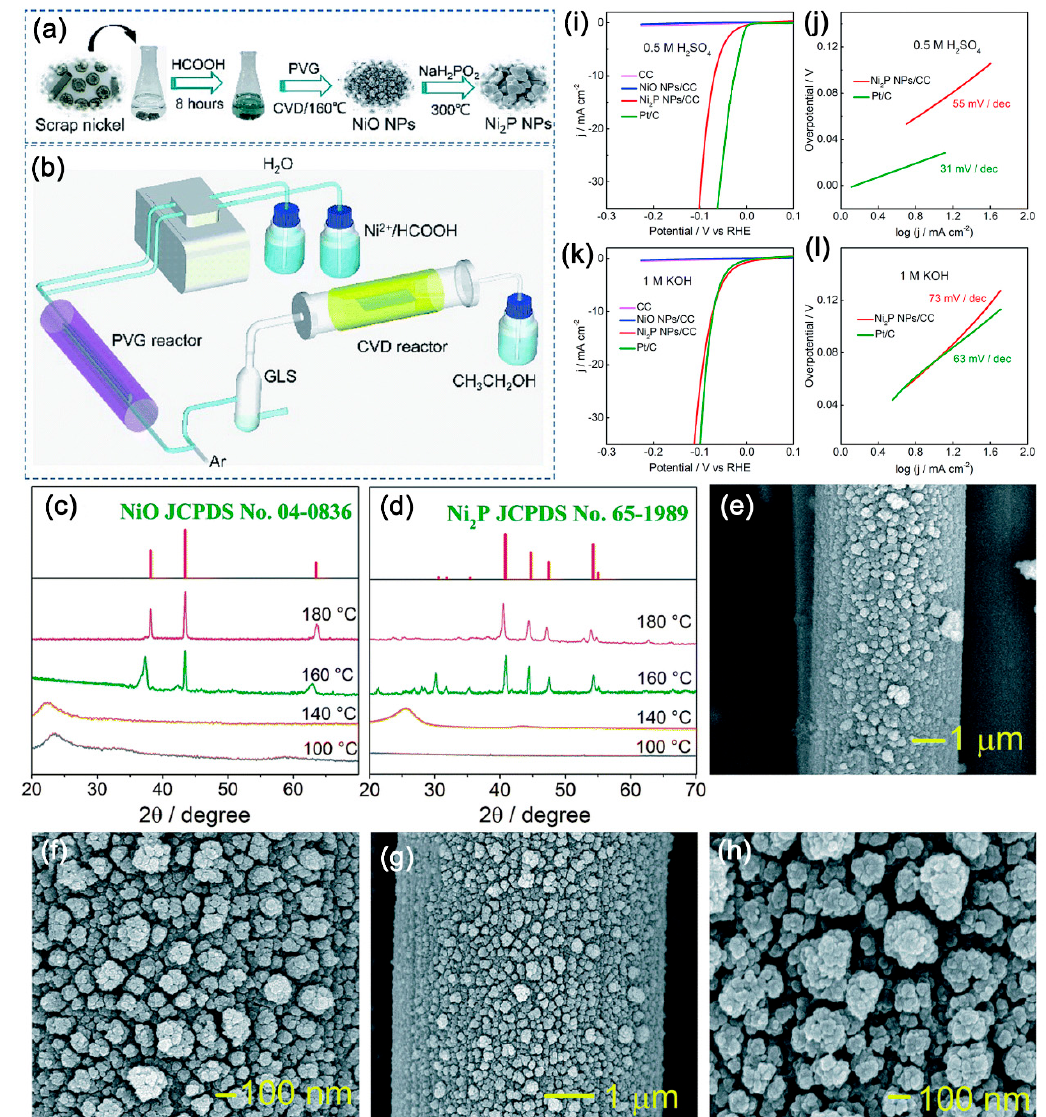
Figure 8. Schematic diagram of Ni 2 P NPs/CC preparation via acidic extraction, PVG, low-temperature CVD, and phosphidation ( a ) and a detailed diagram of PVG ( b ), XRD patterns of NiO NPs ( c ), and Ni 2 P NPs/CC ( d ) prepared at 100, 140, 160, and 180 °C, low- ( e ) and high- ( f ) magnification SEM images of NiO NPs/CC prepared at 160 °C. Low- ( g ) and high- ( h ) magnification SEM images of Ni 2 P NPs/CC. Polarization curves for CC, NiO, and Ni 2 P NPs/CC obtained at 160 °C in 0.5 M H 2 SO 4 ( i ) and 1 M KOH ( k ), and corresponding Tafel slopes ( j , l ). Reproduced with permission from Reference [110], Copyright the Royal Society of Chemistry, 2018.